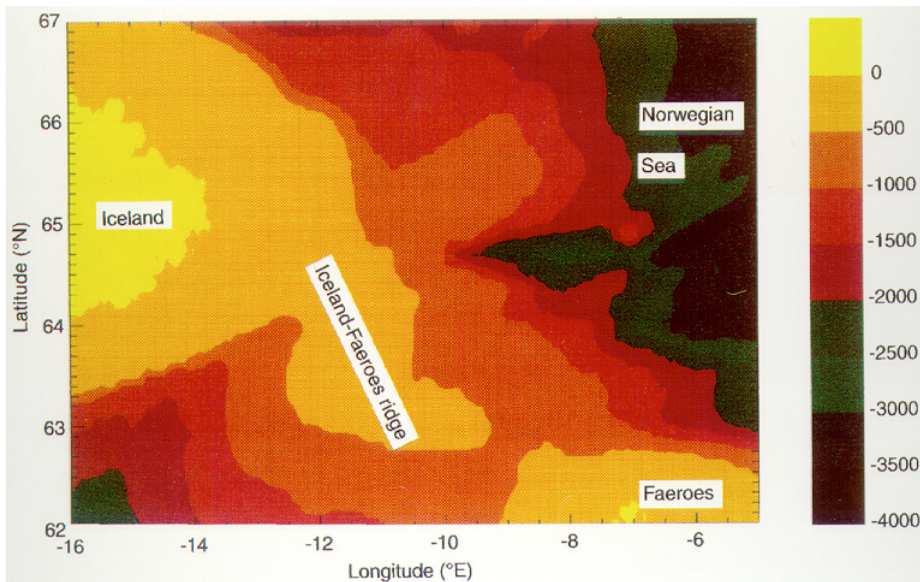
Fig. 1. Bathymetry of the Iceland- Faeroes region, indicating the Iceland-Faeroes ridge. From ETOP05. The depth scale at 500-m intervals is indicated in the colour -